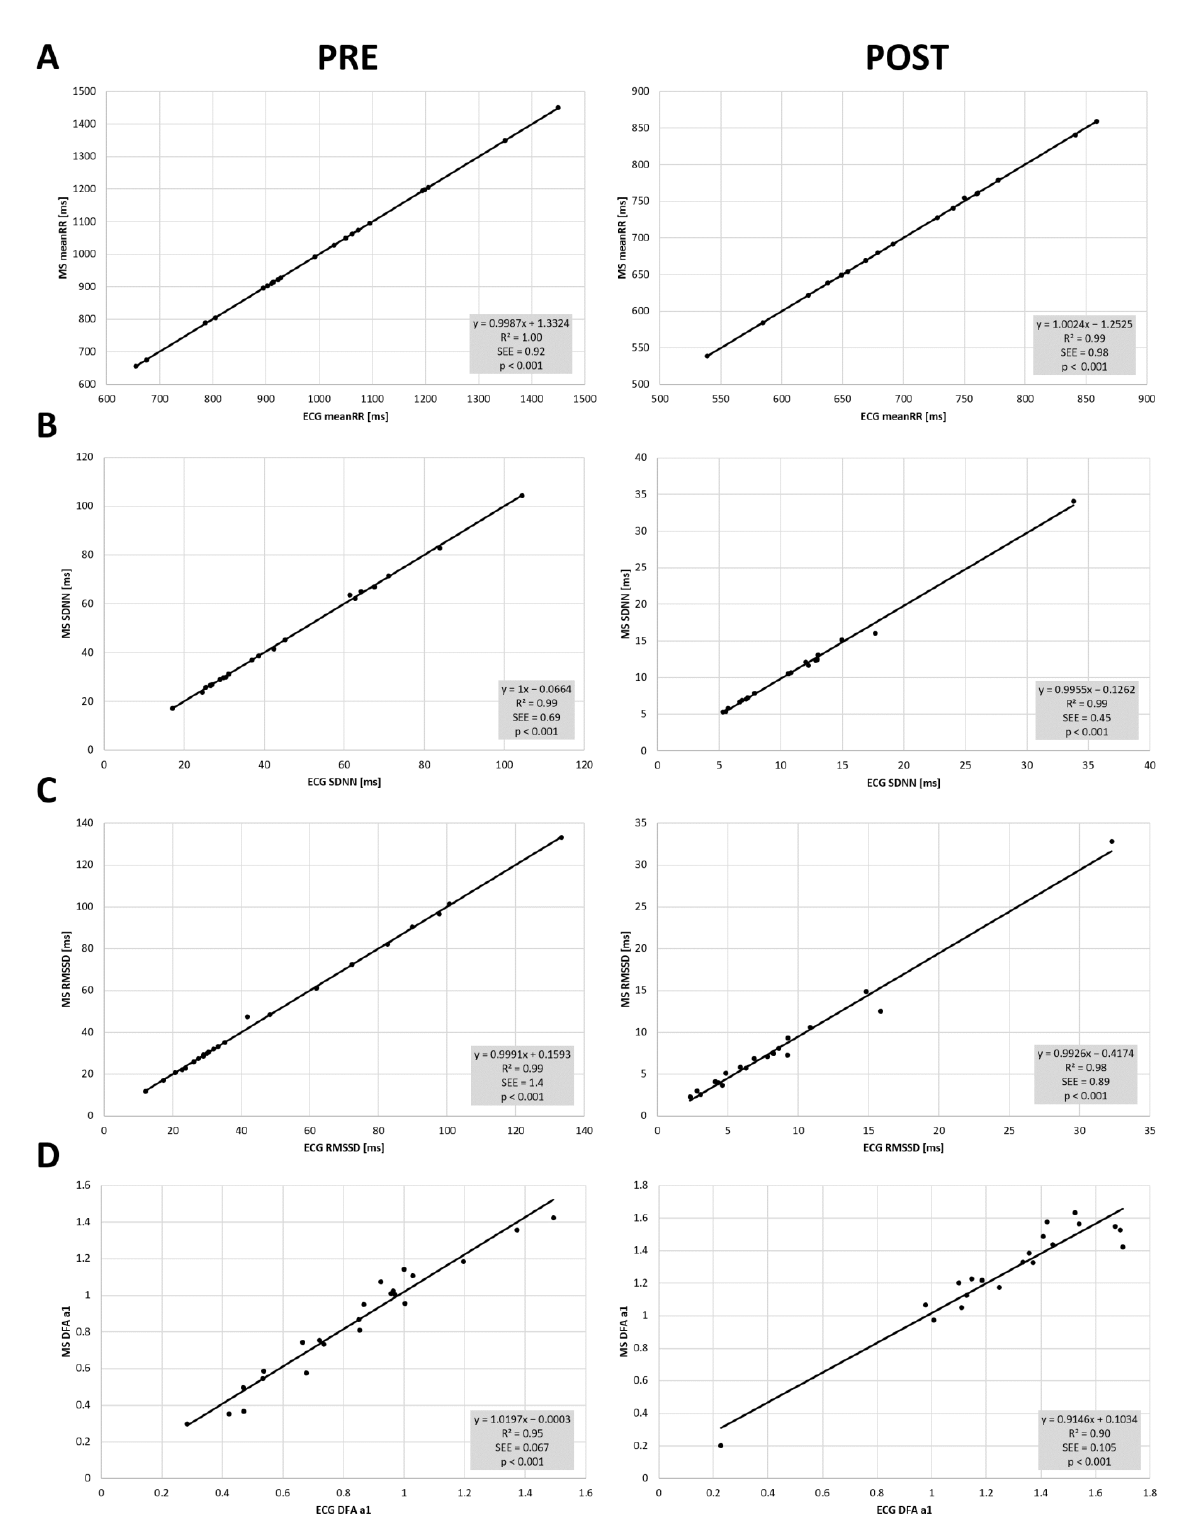
Figure 3. Regression plots for the comparison of the 12 channel ECG (ECG) and the Movesense Medical sensor (MS) during PRE and POST the incremental exercise test for meanRR ( A ), SDNN ( B ), RMSSD ( C ), and DFA a1 ( D ). Slope, coefficient of determination (R 2 ), standard error of estimate (SEE), and p value shown in the bottom right of each